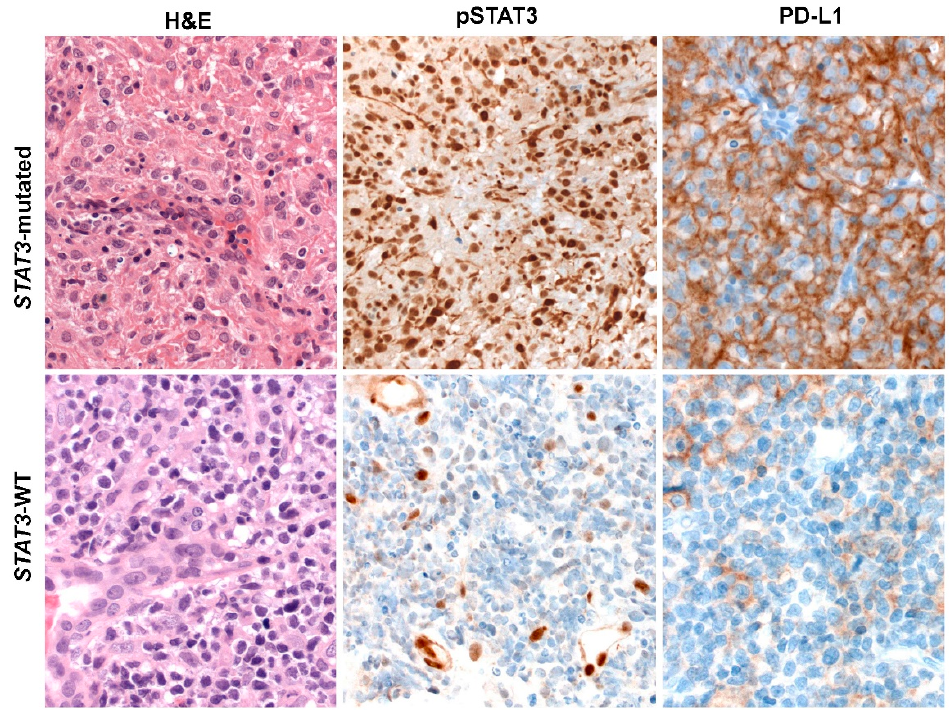
Figure 3. JAK-STAT signaling pathway and immune response evasion disturbances in ENKTCL.